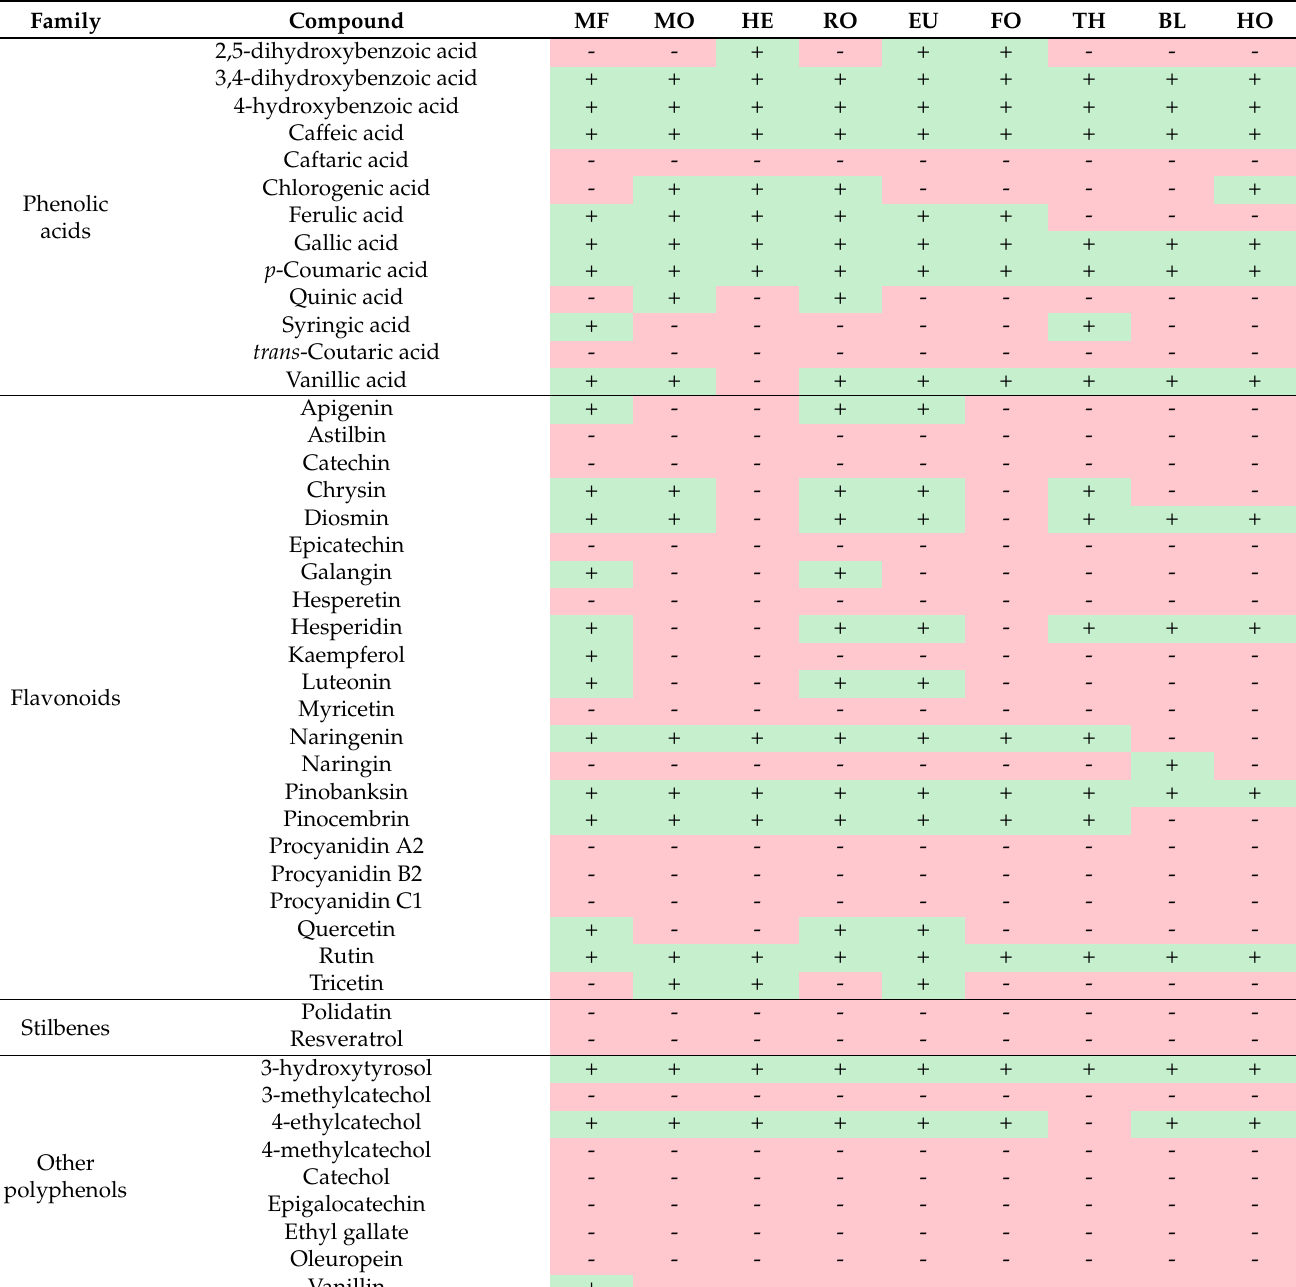
Table 1. Summary of tentative identified and detected polyphenolic compounds in the honey samples according to their botanical variety. BL: Orange/lemon blossom; EU: Eucalyptus; FO: Forest; HE: Heather; HO: Holm oak; MF: Multi-floral; MO: Mountain; RO: Rosemary; TH: Thyme. Detected compounds are marked in green (+), and non-detected compounds in red